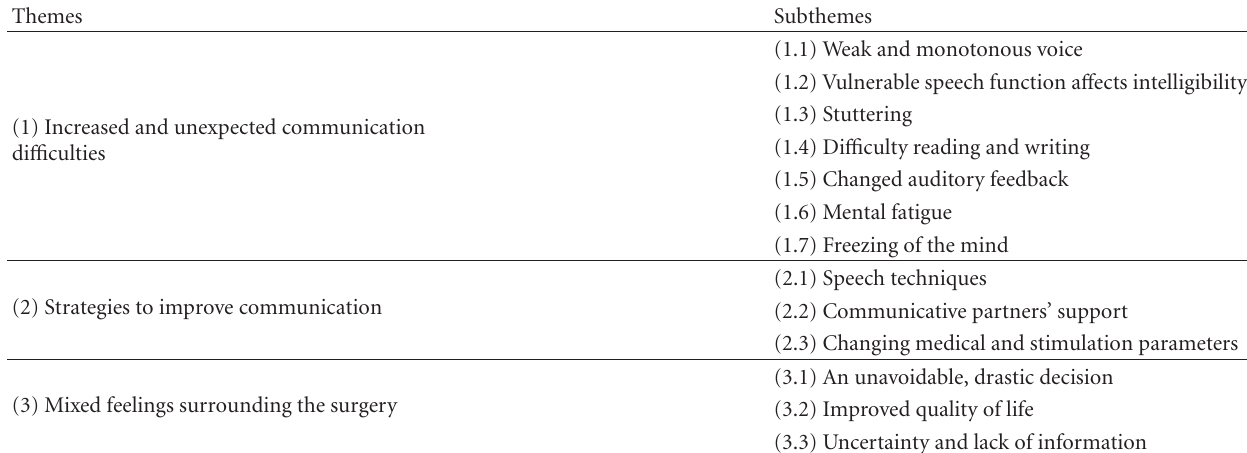
Table 3: Overview of